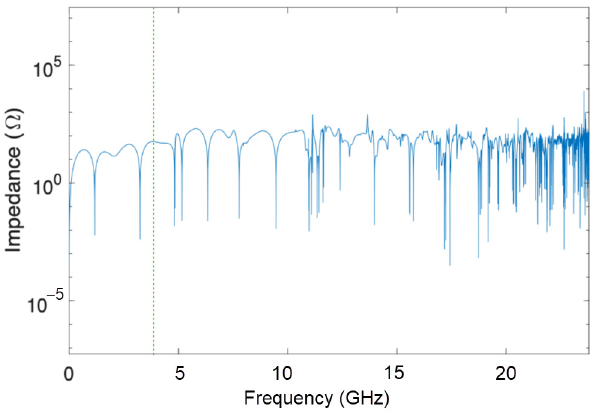
Figure 5. Required voltage and power consumption for 20 mrad deflection in the kicker with 14 mm gap.